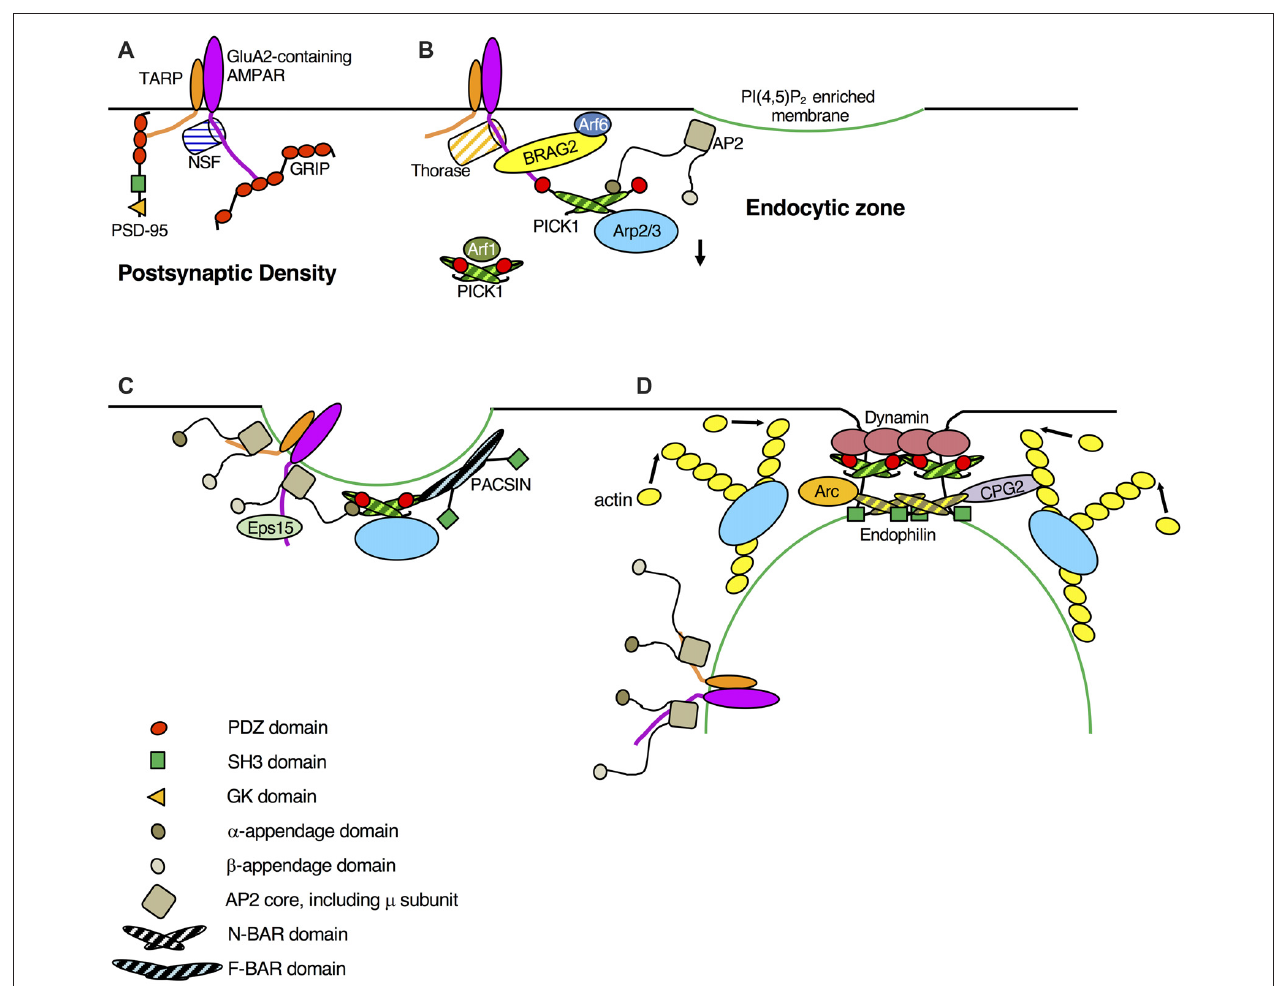
FIGURE 1 | Schematic showing dynamic protein-protein interactions in AMPA receptor (AMPAR) endocytosis. (A) GluA2-containing AMPARs at the synapse are bound to post-synaptic density-95 (PSD-95) via transmembrane AMPAR regulatory proteins (TARPs) and to GRIP via GluA2. NSF activity prevents protein interacting with C-Kinase 1 (PICK1) binding to GluA2. (B) As a result of long-term depression (LTD) induction (NMDA receptor (NMDAR) or metabotropic glutamate receptor (mGluR) stimulation), TARP dephosphorylation disrupts TARP-PSD-95, GluA2 S880 phosphorylation and Thorase activity disrupt GluA2-GRIP. Ca 2 + directly enhances GluA2-PICK1 and disrupts GluA2-NSF, deactivation of Arf1 promotes PICK1-Arp2/3 (inactive). GluA2 Y876 dephosphorylation enhances GluA2-Brefeldin-Resistant Arf-G2 (BRAG2), which in turn activates Arf6, causing a local increase in PI(4,5)P 2 concentration, and consequent clustering of